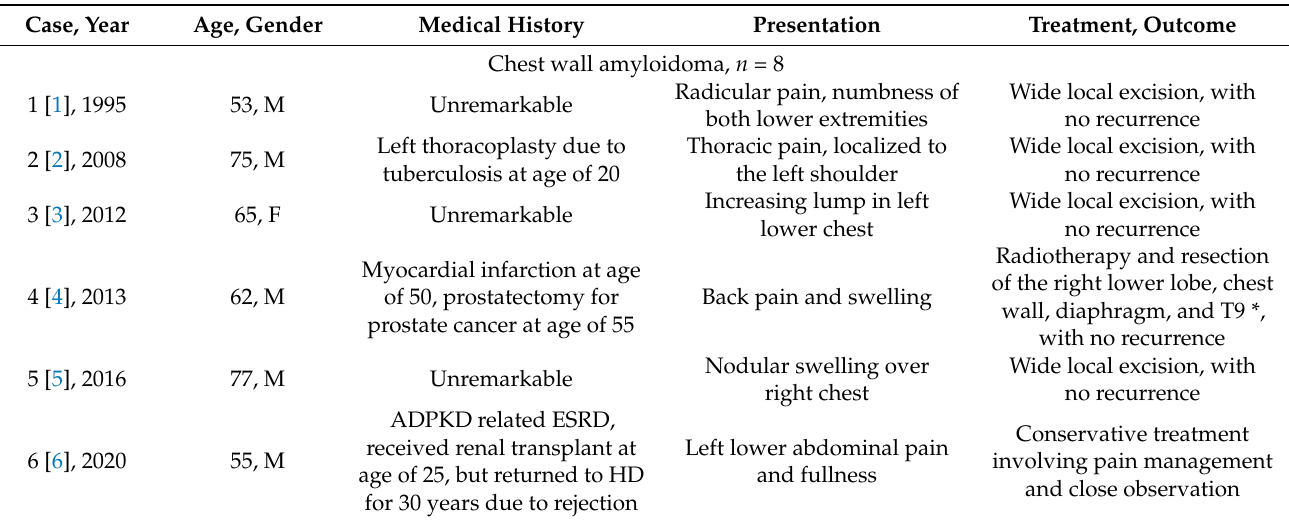
Table 1. Reported cases of chest wall